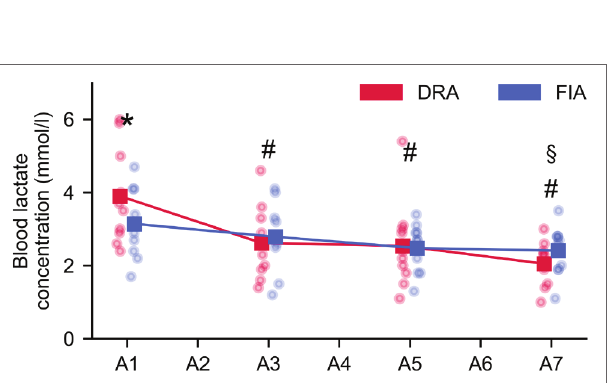
FIGURE 4 | Evolution of lactate during the series of seven apneas (A1–A7 = measurement after the first–seventh apnea). The blue graph represents the average for FIA, while the red graph represents the average for DRA. * = significant difference between FIA and DRA at p < 0.05; § = significantly different from BL for FIA; and # = significantly different from BL for DRA.